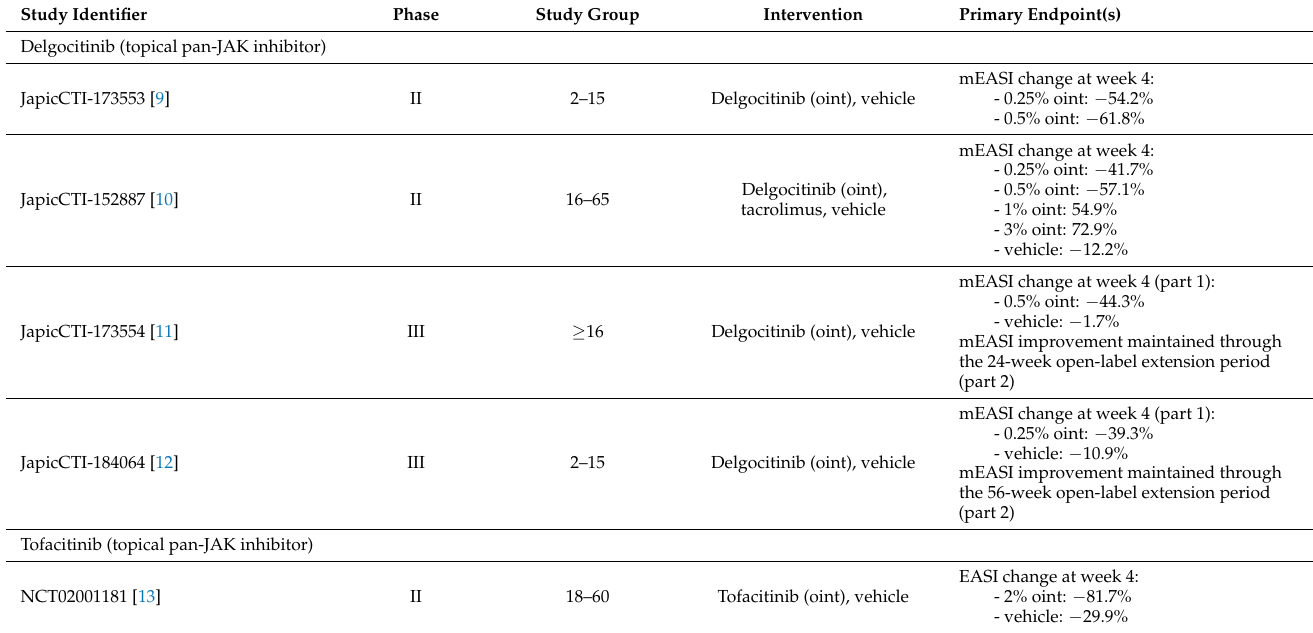
Table 2. Selected studies and registered clinical trials on currently available JAK inhibitors for the treatment of atopic dermatitis.